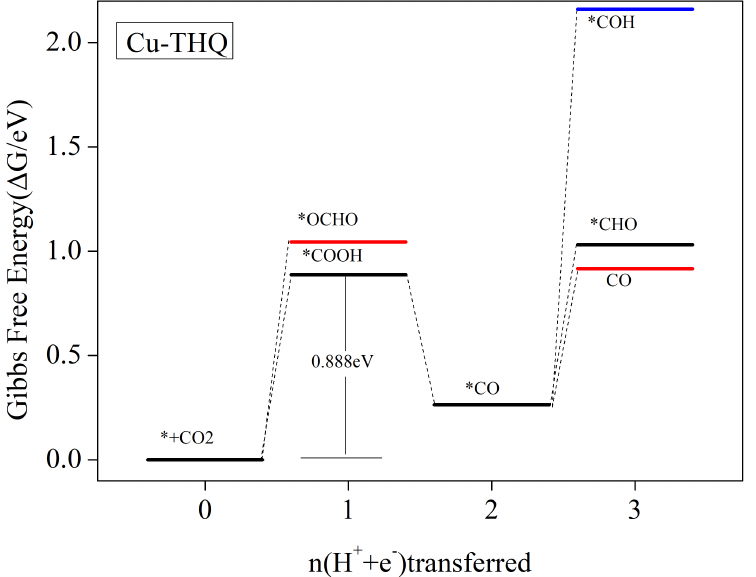
Figure 9. The Gibbs free-energy curve of CO 2 RR along the most favorable route of Cu-HQ at zero potential. The CO 2 molecules with clean catalytic surfaces in the gas phase are assigned a free energy of